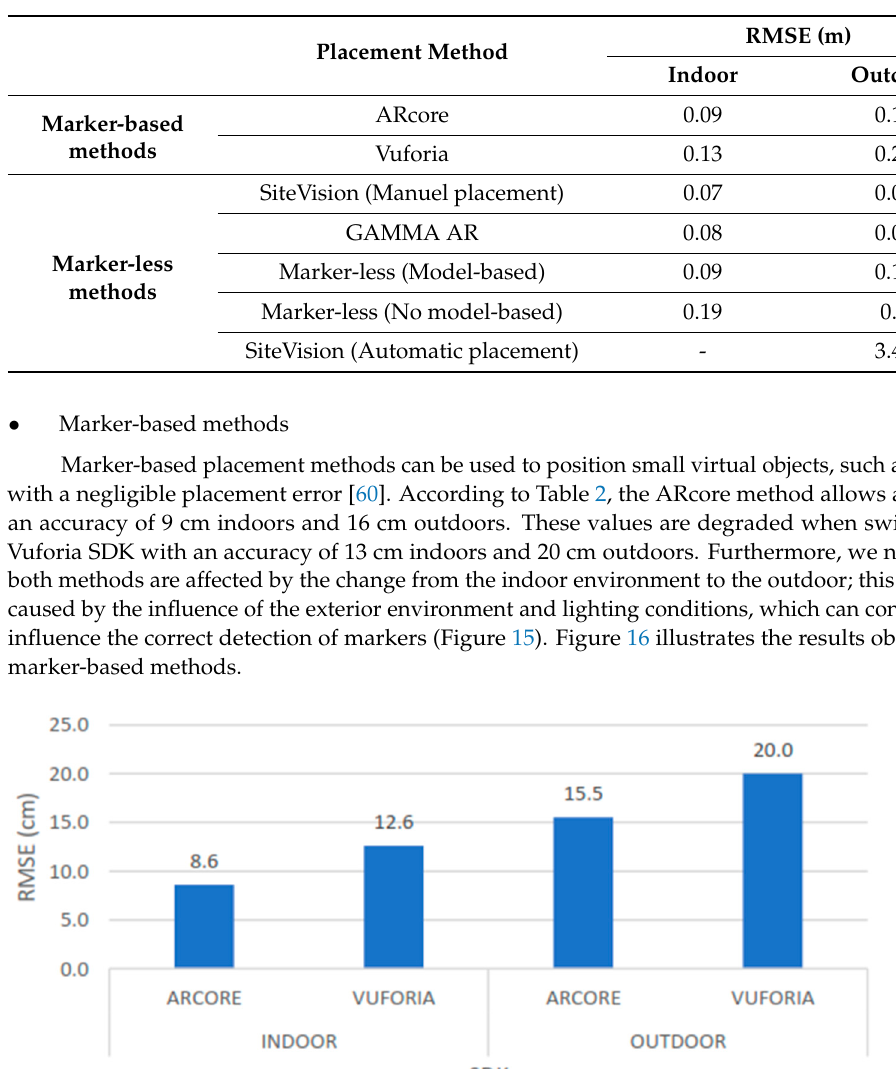
Table 2. The accuracy of placement (RMSE) for the studied methods.